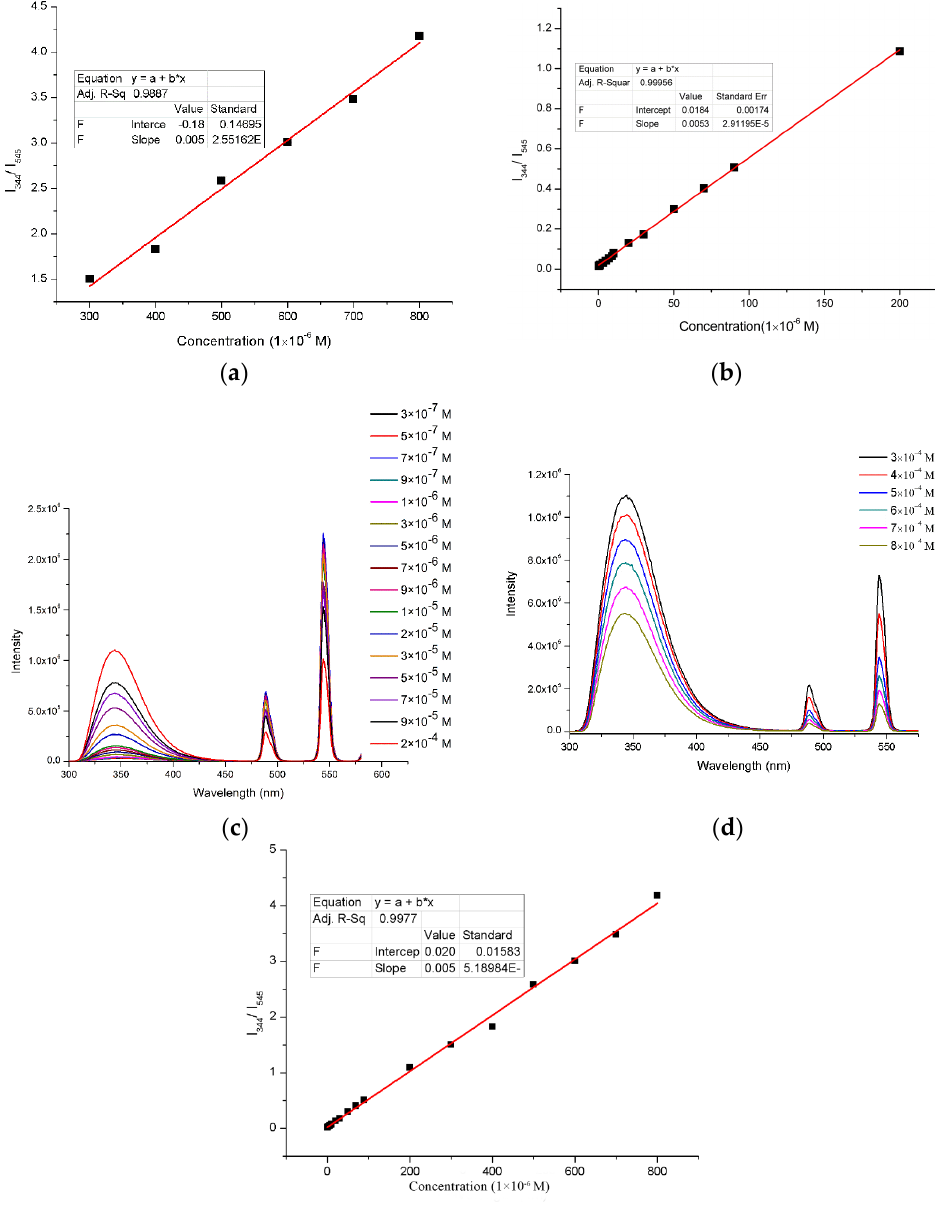
Figure 7. ( a ) Plot of I 344 /I 545 versus the sesamol content (1 × 10 − 7 to 2 × 10 − 4 M) in ethanol solution ( λ ex = 294 nm); ( b ) Plot of I 344 /I 545 versus the sesamol content (3 × 10 − 4 to 8 × 10 − 4 M) in ethanol solution; ( c ) Emission spectra of Tb(3+)@Sr-MOF as a function of the sesamol concentration (from top: 1 × 10 − 7 to 2 × 10 − 4 M) in ethanol solution; ( d ) Emission spectra of Tb(3+)@Sr-MOF as a function of the sesamol concentration (3 × 10 − 4 to 8 × 10 − 4 M) in ethanol solution; ( e ) Plot of I 344 /I 545 versus the sesamol content (1 × 10 − 7 to 8 × 10 − 4 M) in ethanol solution ( λ ex = 294 nm). The CIE (Commission International deLEclairage) diagram of the Tb(3+)@Sr-MOF treated with different concentrations of sesamol was performed. As shown in Figure 8, luminescent color of Tb(3+)@Sr-MOF tuned from blue to green when excited at 294 nm. The results show that the luminescent ratio (I 344 /I 545 ) is highly sensitive to the concentration of sesamol. The feature could be used served for sensing of different concentrations of sesamol with high selectivity and sensitivity and without any addition.